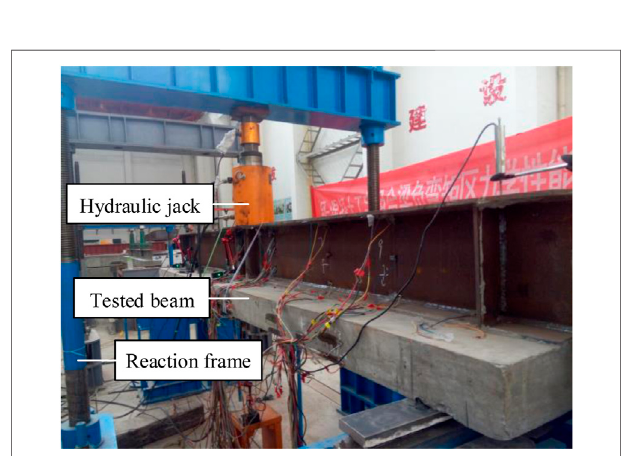
FIGURE 2 | Static test set-up.